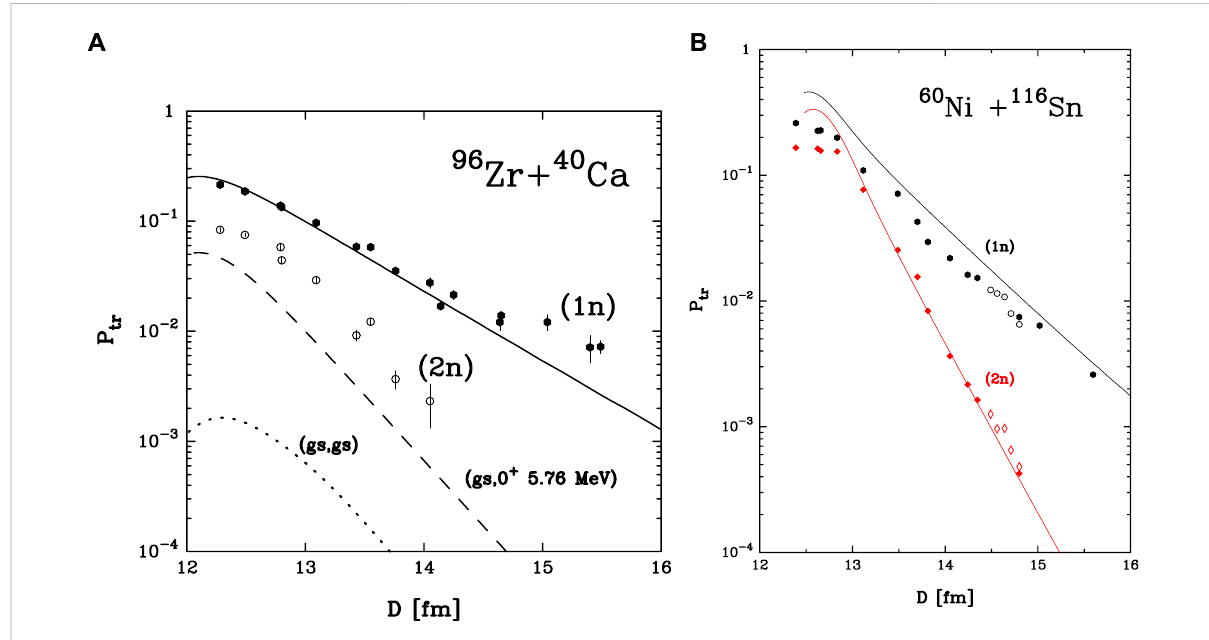
FIGURE 2 Theoretical transfer probabilities P tr for the one- and two-neutron transfer (lines) in comparison with the experimental data (symbols) for the 96 Zr+ 40 Ca (A) and 116 Sn+ 60 Ni (B) systems plotted as a function of the distance of closest approach D (A) The full line represents the inclusive transfer probability for one-neutron transfer, the dotted line the ground-to-ground state transition for the two-neutron transfer, and the dashed line the transition to the fi rst 0 + excited state at 5.76 MeV in 42 Ca [14] (B) Open symbols correspond to the results from the angular distribution in direct kinematics while solid symbols refer to the excitation function measurement performed in inverse kinematics